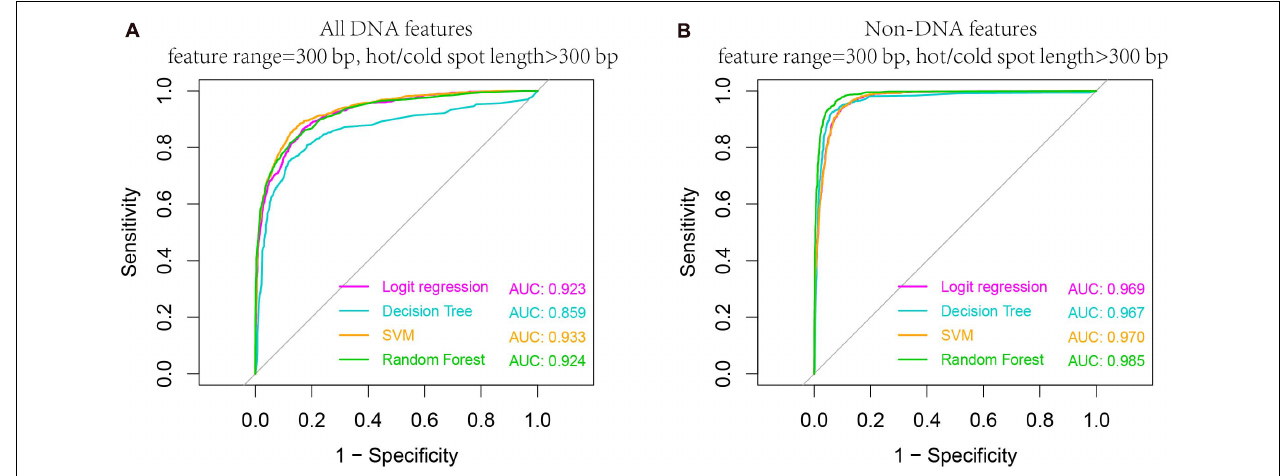
FIGURE 8 | Higher AUC values are obtained when predicting larger hotspots ( > 300 bp). Results are based on combined decision values inferred from five-fold cross validation by using all DNA features (A) and non-DNA features (B) . See Table 1 for feature details.